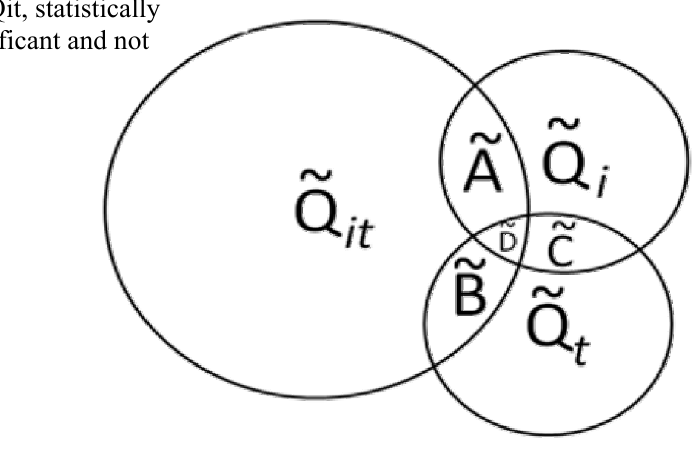
and covariates found significant in the parent case-control study these cluster types identify where, when, and to whom to allocate unexplained (e.g., excess) risk (Table 1). All Qit,